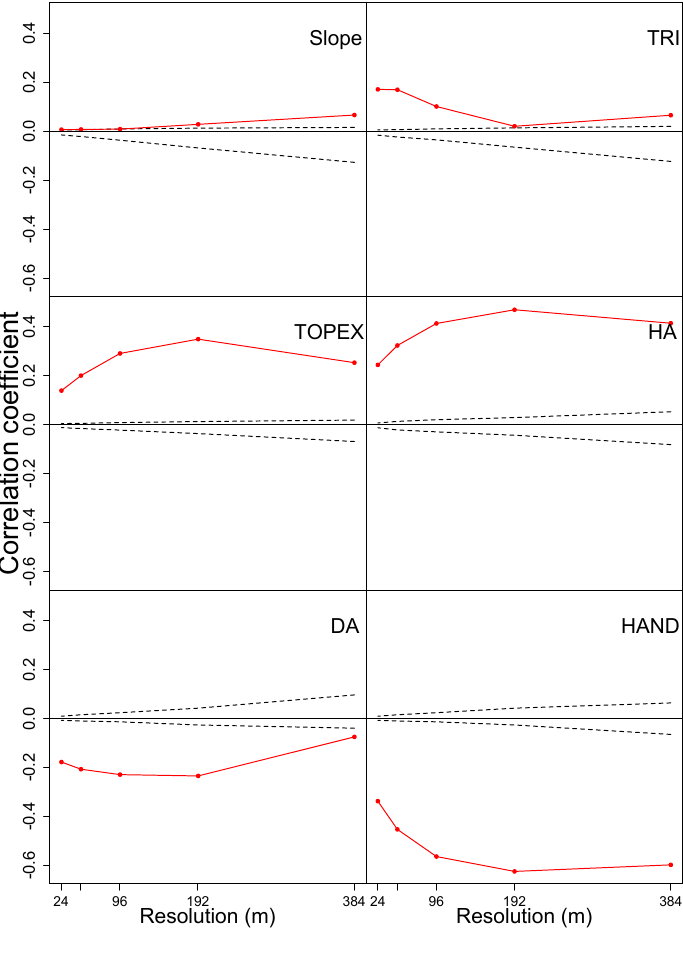
Figure 4. Correlation coefficients between smoothed DCM and smoothed topographic variables (defined in Table 1), as a function of the smoothing scale. Dotted lines represent the 95% confidence intervals of Pearson’s test computed from 999